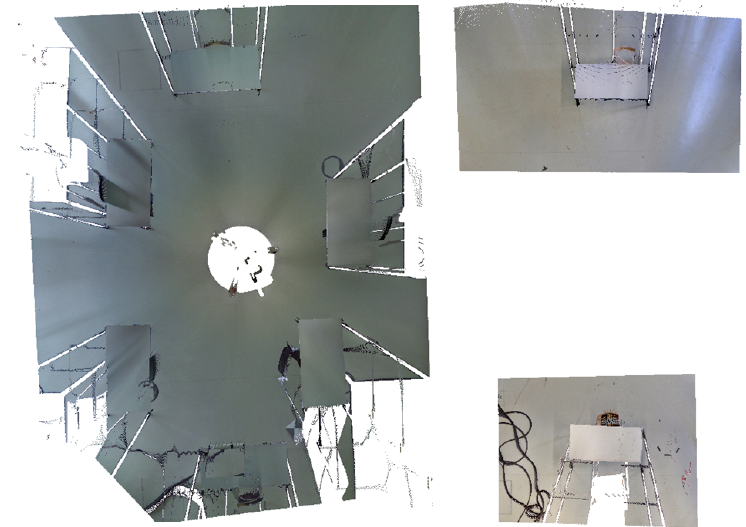
Figure 11. Points to be examined without semantic segmentation. Objects of the chair, table and floor classes, as well as scanning artifacts, are